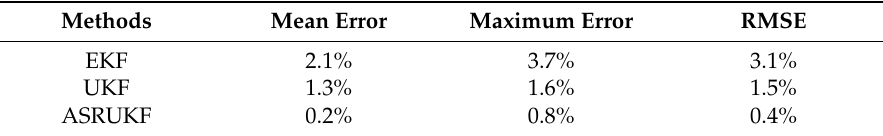
Table 4. Comparison of SOC estimation error in the UDDS